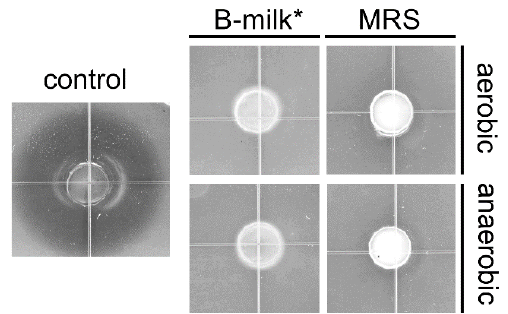
Figure 2. Analysis of anti-listerial compounds secreted by Lrh-FQ using soft-agar well diffusion assays with L. innocua BL 86/26 as an indicator strain. Tested were saturated cultures of Lrh-FQ grown in MRS or B-milk supplemented with 0.5% glucose and 0.5% tryptone (B-milk*) under aerobic and anaerobic conditions, as well as a saturated culture of a sakacin P-producing strain grown in MRS